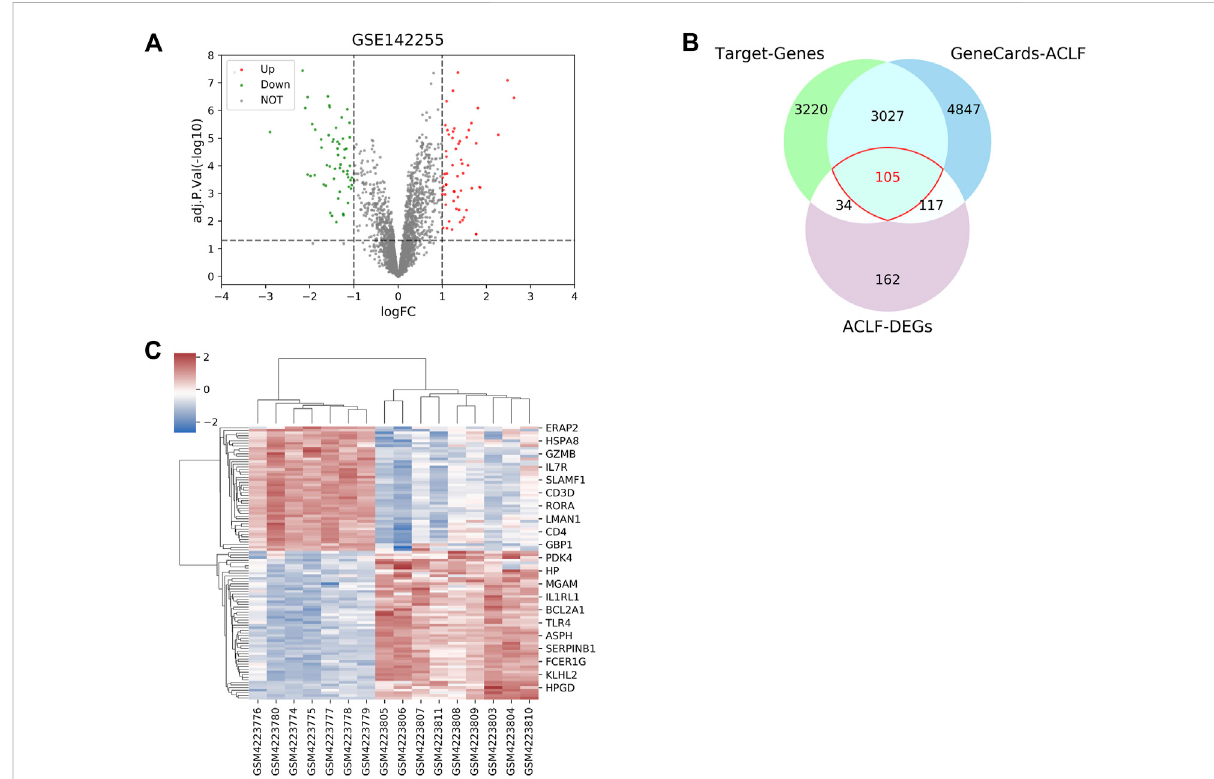
FIGURE 1 Drug targets of the Wenyang Jiedu Huayu formula and disease targets of acute-on-chronic liver failure (ACLF). (A) Differentially expressed genes (DEGs) between normal and ACLF samples according to GSE142255. (B – C) DEGs, drug targets retrieved from PubMed and PubChem, and disease targets retrieved from GeneCards were compared, and overlapping genes were further